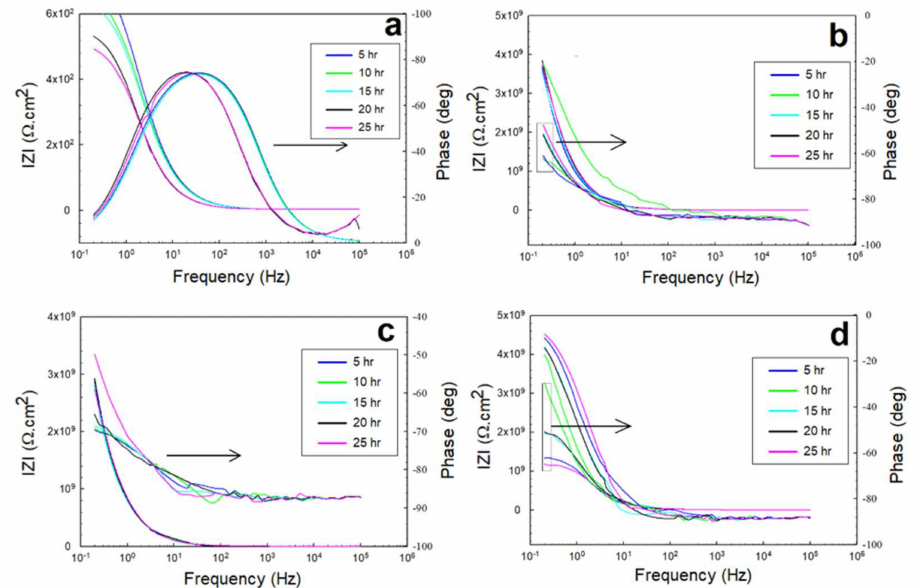
Figure 12. EIS Bode plots of the 0.5 M HCl solution for: ( a ) exposed steel, ( b ) glass/epoxy, ( c ) Kevlar/epoxy, and ( d ) epoxy